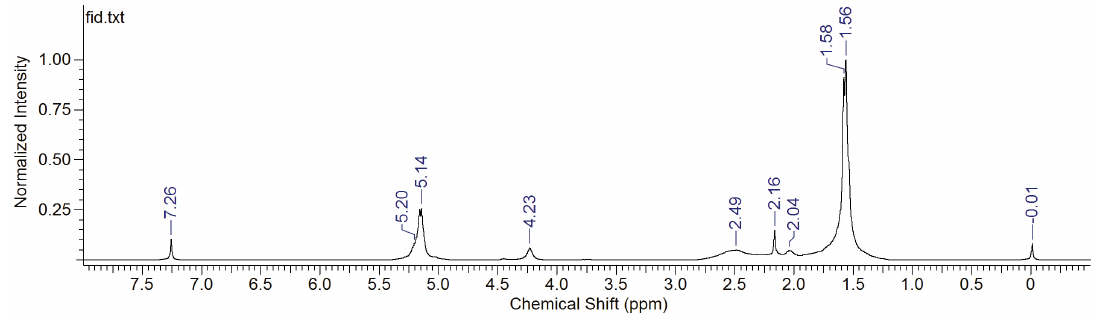
Figure 4. H 1 –NMR PDLLA